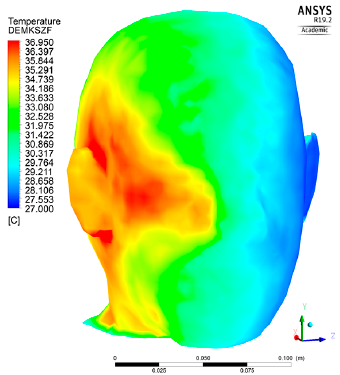
Energies 2019 , 12 , x FOR PEER REVIEW Figure 6. Face surface temperature distribution, blown from left. Figure 6. Face surface temperature distribution, blown from left.